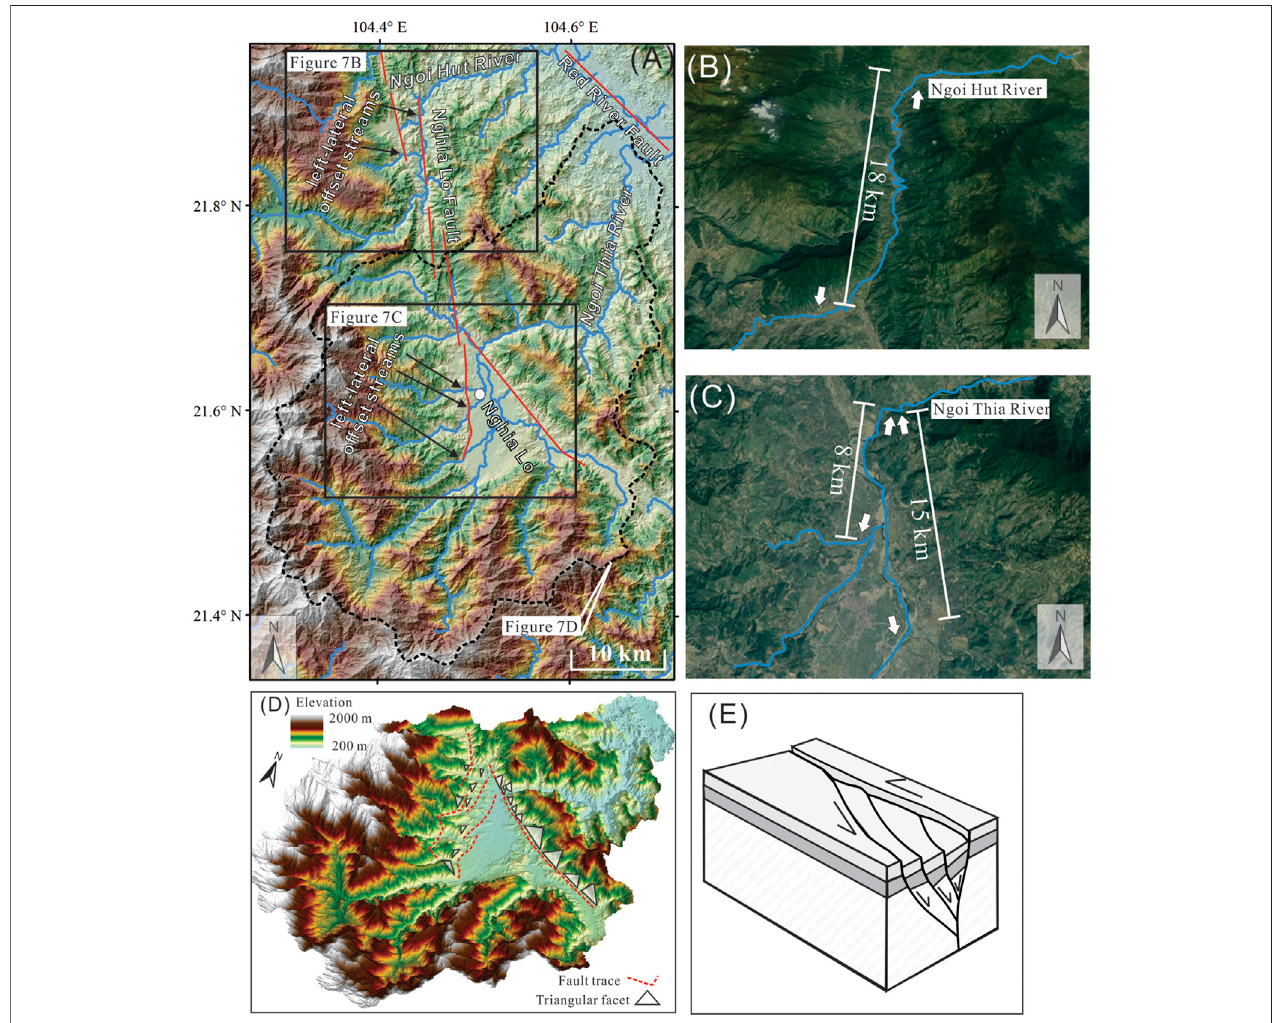
FIGURE 7 | (A) 12.5 m DEM imagery showing topographic features and fault systems in the northeastern side of the south part of the Tule mountain range (for locationseein Figure3 ); (B,C)